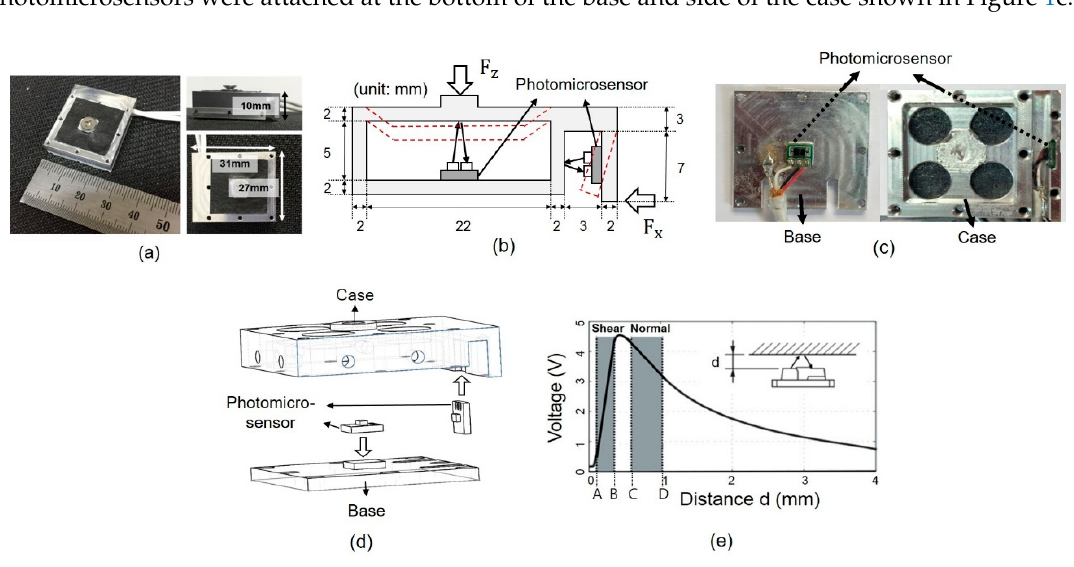
Figure 1. Design of the custom biaxial force sensor. ( a ) Size of the custom force sensor. ( b ) Measurement principle of the force sensor and detailed dimensions of the sensor. ( c ) The location of the printed circuit board (PCB) of the photomicrosensor. ( d ) Assembly diagram of the force sensor. ( e ) Voltage output according to the displacement of the photomicrosensor and the sensing range for shear (A–B) and normal (C–D) directions.